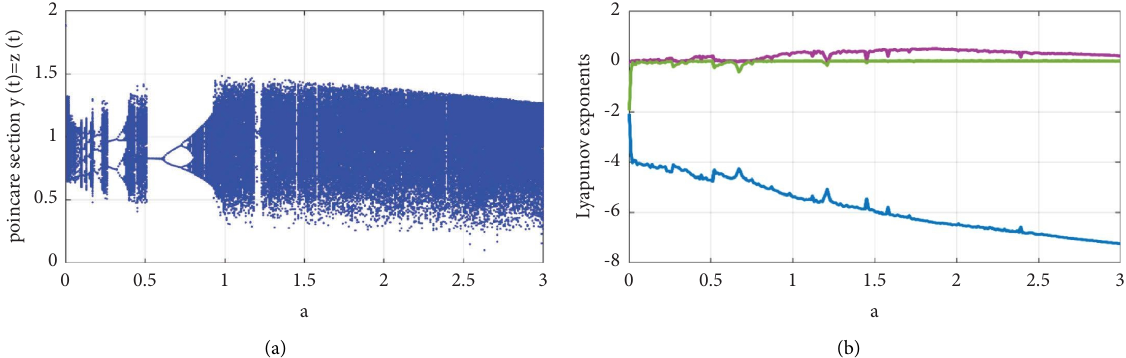
Figure 4: (a) Te system bifurcation diagram and (b) the corresponding Lyapunov exponents, utilizing a as the bifurcation parameter with fxing the other parameters constant such that b � 7 ,c � 5 ,f � 8 ,g � 11 , and r � 4.